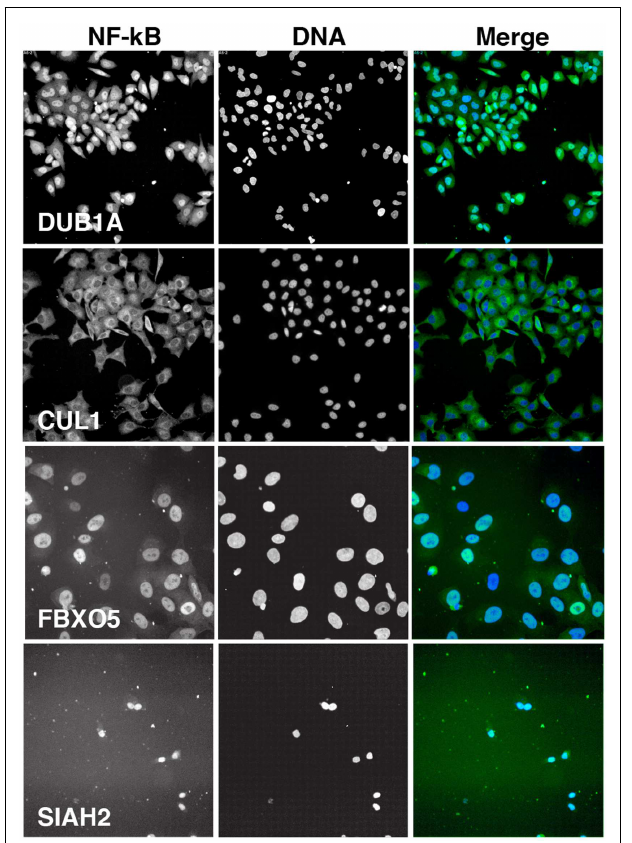
FIGURE 5 | Representative images of HeLa cells treated with the indicated siRNA pools and incubated withTNF for 30min . Each panel is shown at the same scale. NF- κ B is shown in green in the merged image and DNA is shown in blue. CUL1 siRNA is a representative inhibitor of NF- κ B nuclear accumulation, FBXO5 siRNA results in enlarged nuclei, and SIAH2 siRNA leads to extensive cell death.